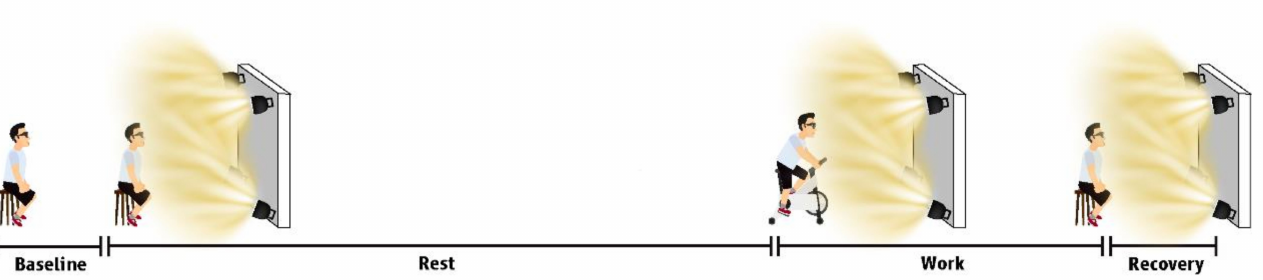
Figure A4. The experimental protocol of laboratory